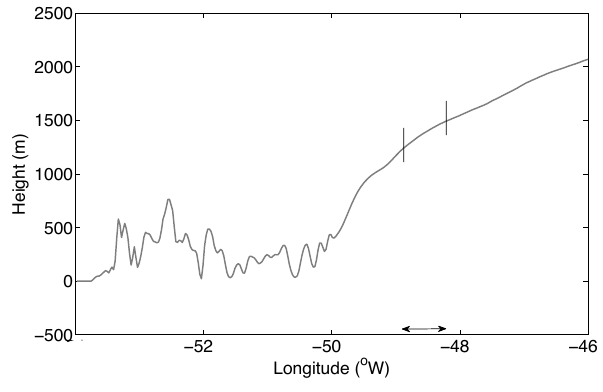
Fig. 7. Elevation profile along 67 ◦ N. The vertical black lines and arrow indicate the position of the dark region. The margin of the ice is at 50 ◦ W. The elevation data is from Bamber et al.